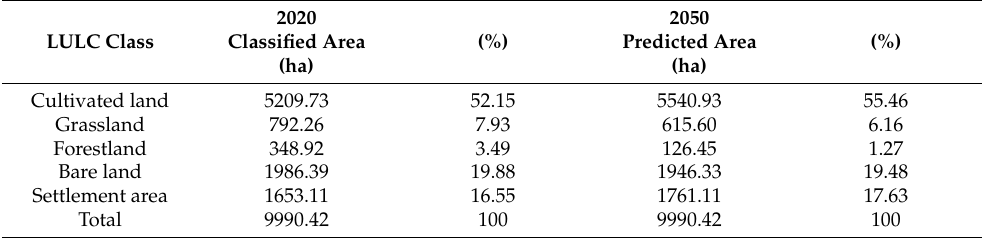
Table 15. Comparison between LULC map 2020 and predicted CA-Markov LULC map of 2050. LULC